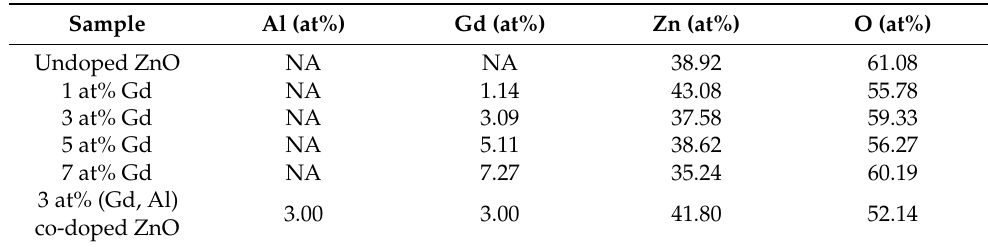
Table 2. Elemental composition of undoped ZnO, various Gd concentrations of Gd-doped ZnO, and (Gd, Al) co-doped ZnO